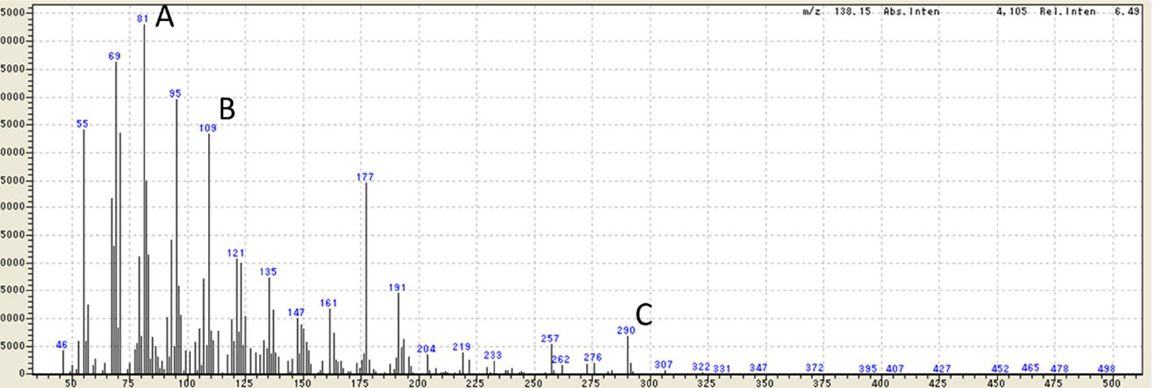
Figure 2. Mass chromatogram of sclareol obtained using GC-MS analysis in the full scan mode. The vertical axis shows the signal intensity, and the horizontal axis shows m / z . We analyzed (A) m / z 81, (B) m / z 109, and (C) m / z 290 in the GC-MS analysis as monitor ions.